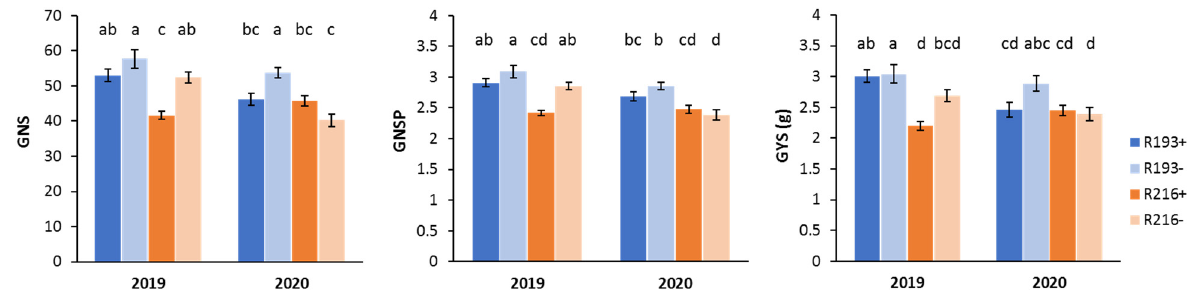
Figure 4. Significant Genotype × Year effect on spike yield traits measured in 2019 and 2020 for 7el 1 + 7el 2 recombinants (hom+) and their controls (hom − ) (GNS, grain No./spike; GNSP, grain No./spikelet; GYS, grain yield/spike).; error bars represent standard errors of means; letters above the histograms correspond to the ranking of the Tukey test at p < 0.05 level.